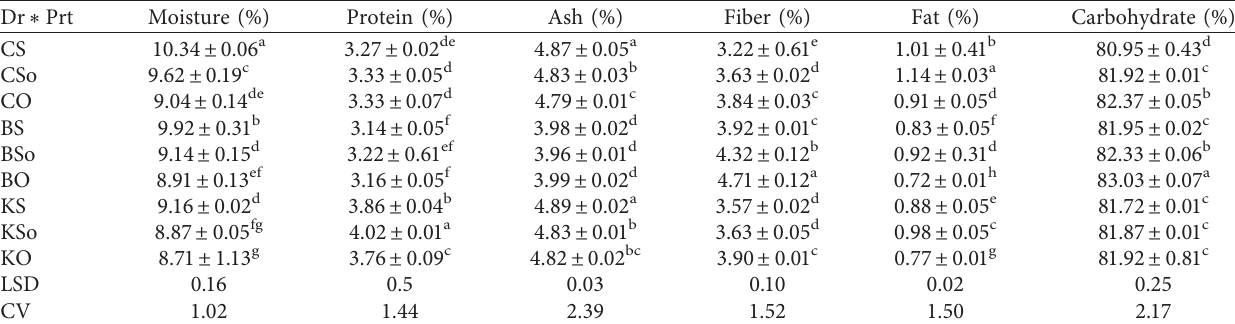
Table 2: Proximate composition of anchote flour as affected by pretreatments and drying methods. Dr ∗